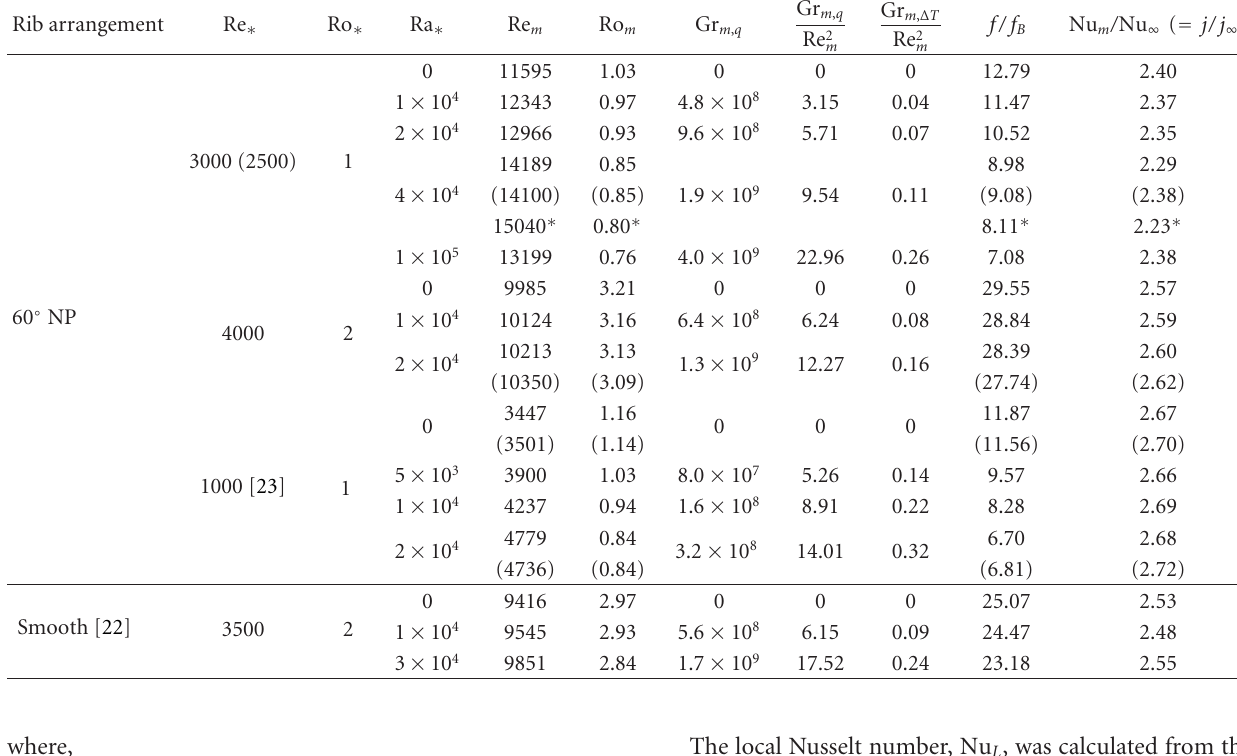
Table 1: Dimensionless number range of this study and the duct-averaged values of f and Nu m (the values in parentheses in the second line are for higher grid resolution of 101 × 101 × 1569. The values with asterisks are for quasi-DNS). Rib